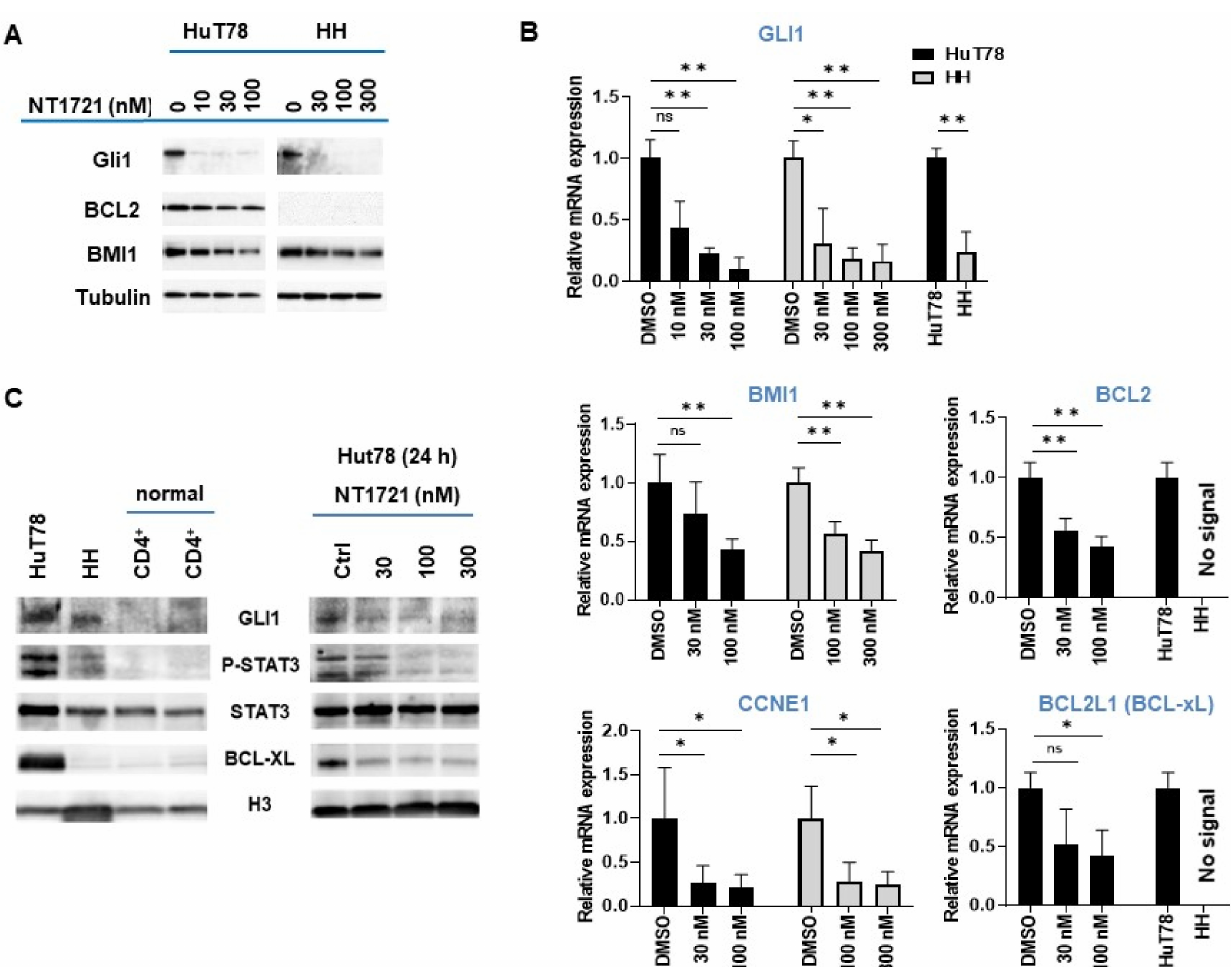
Figure 2. NT1721 downregulated GLI and GLI target genes in CTCL cells. ( A ) Protein expression levels were assessed by Western blot after 24 h treatment with NT1721. ( B ) QPCR analysis of gene expression. The data were analyzed using GAPDH as the reference gene and represent the mean ± SD from 3 independent experiments. (* indicates p ≤ 0.05; ** indicates p ≤ 0.01) ( C ) GLI1, pSTAT3, STAT3 and BCL-xL protein expression in normal CD4 + cells, CTCL cells and NT1721-treated CTCL cells. Original Western Blots of Figure 2A,C available in Figure